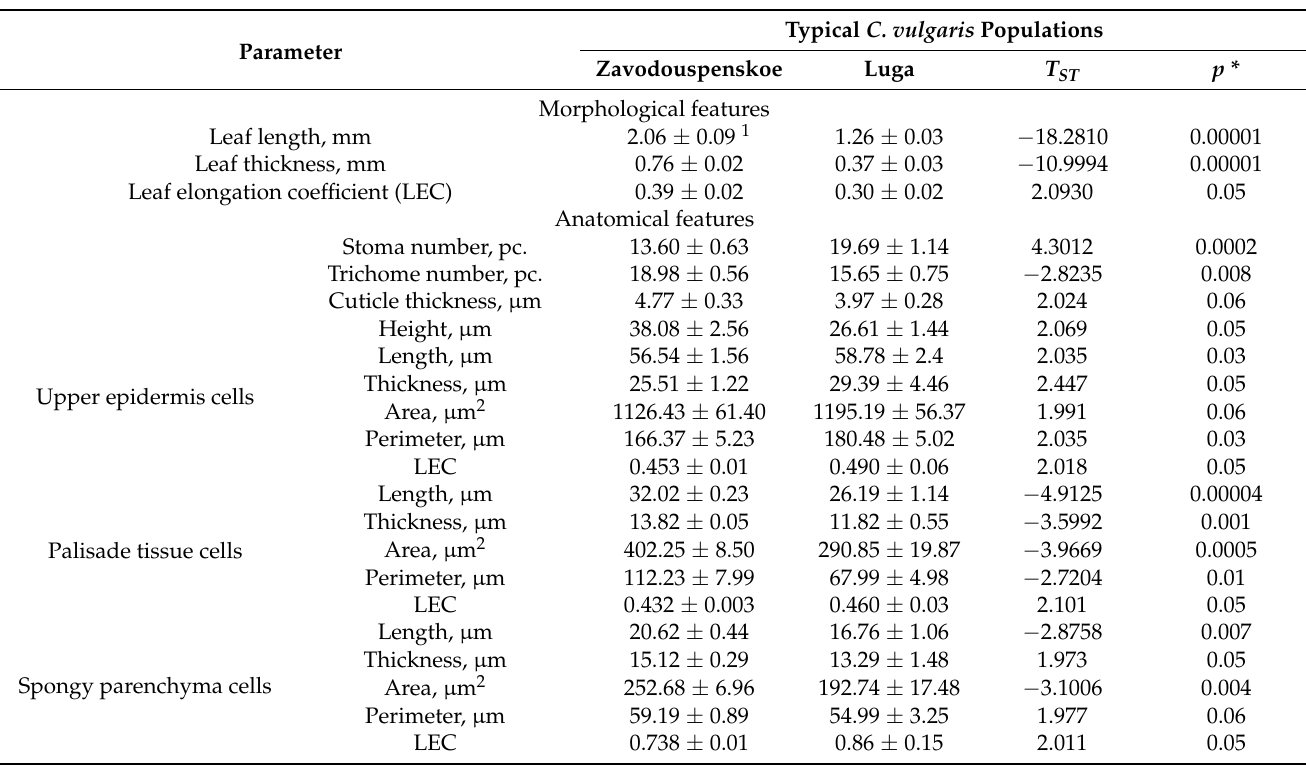
Table 2. Leaf morphological and anatomical parameters of C. vulgaris in typical Pritobolye (Zavodous- penskoe) and Baltic (Luga)